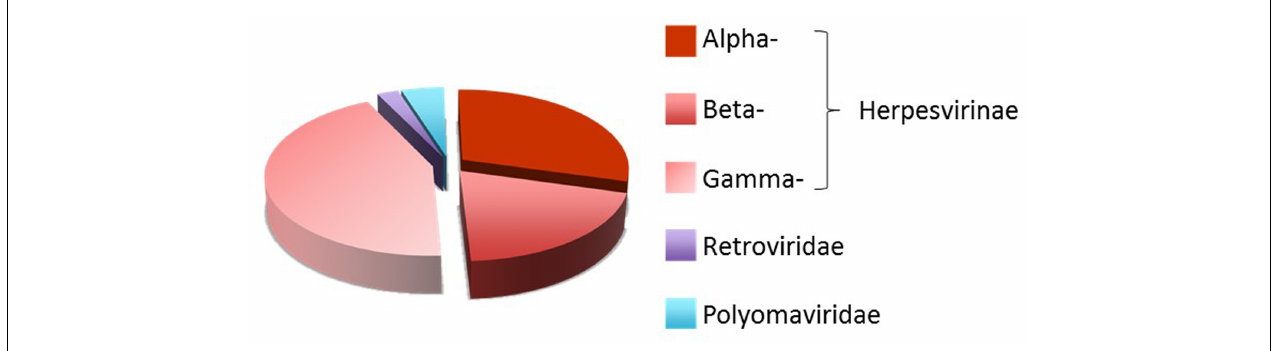
FIGURE 1 | Distribution of human viral miRNAs. Distribution of human viral-encoded miRNAs listed in the miRBase collection (http://www.mirbase.org/) (Kozomara and Griffiths-Jones, 2014).